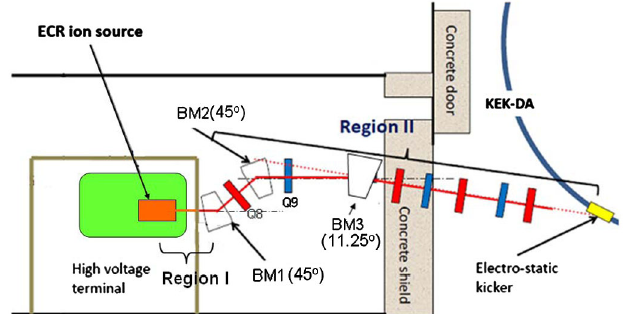
FIG. 10. LEBT line from the ECRIS to the DA ring.